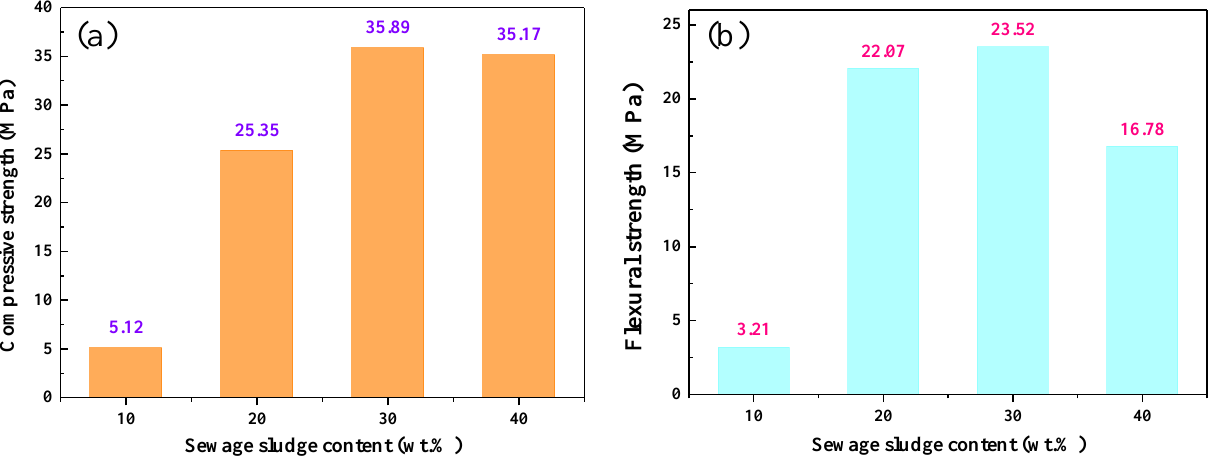
Figure 7. Compressive strength and flexural strength of the ceramic bricks with various sewage sludge contents. ( a ) Compressive strength; ( b ) flexural strength.